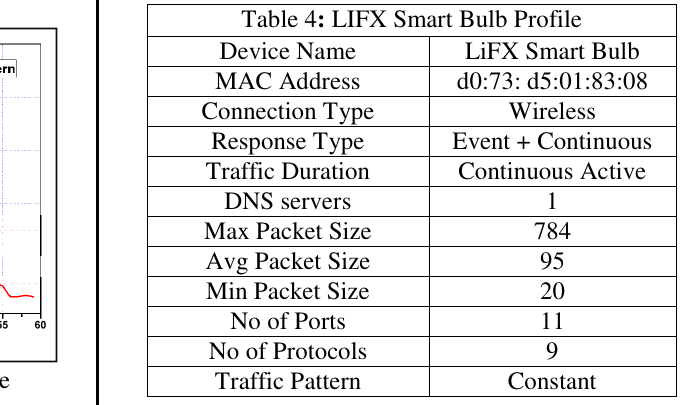
Fig. 11: Withings Smart Scale Activity Cycle Pattern Device activity traffic is shown in Fig. 12. Device traffic contains 60 packets in a single activity, and the duration of traffic is less than one minute.